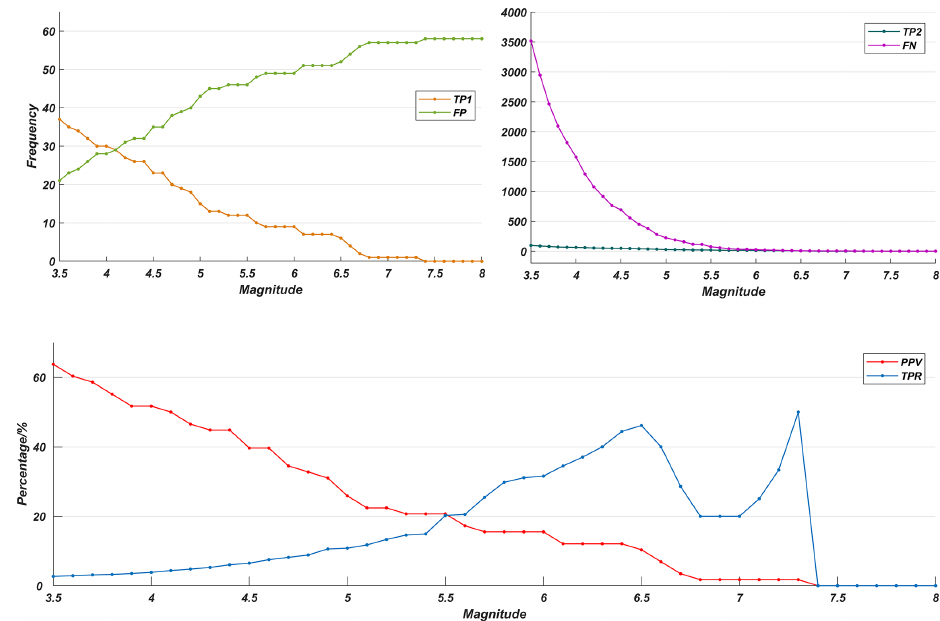
Figure 9. The statistical results of earthquakes including period C (from April to July 2008) and the curves TP1, FP, TP2, FN, PPV, and TPR, which correspond to the examples presented in Table 2.